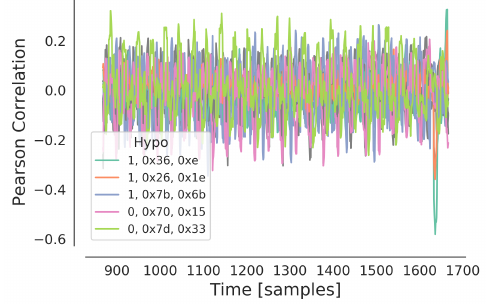
Figure 32: Pearson Correlation coefficients in Step 1 with 256 traces.